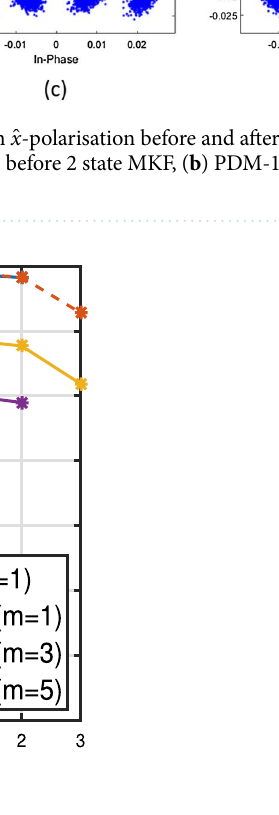
100 kHz and 12 spans for different =